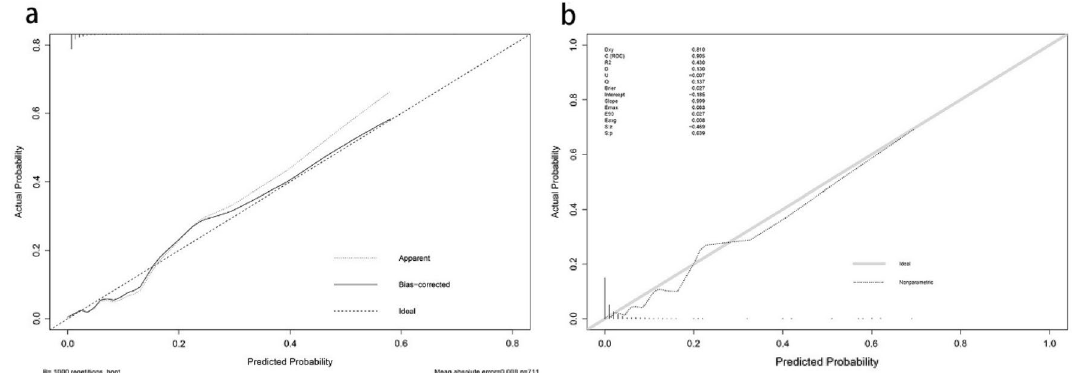
Figure 4. Comparison of the calibration curves of the nomogram in the training cohort ( a ) and the validation cohort ( b ). In the calibration curve, the higher the overlap between the predicted curve and the ideal curve, the better the consistency between the predicted probability and the true